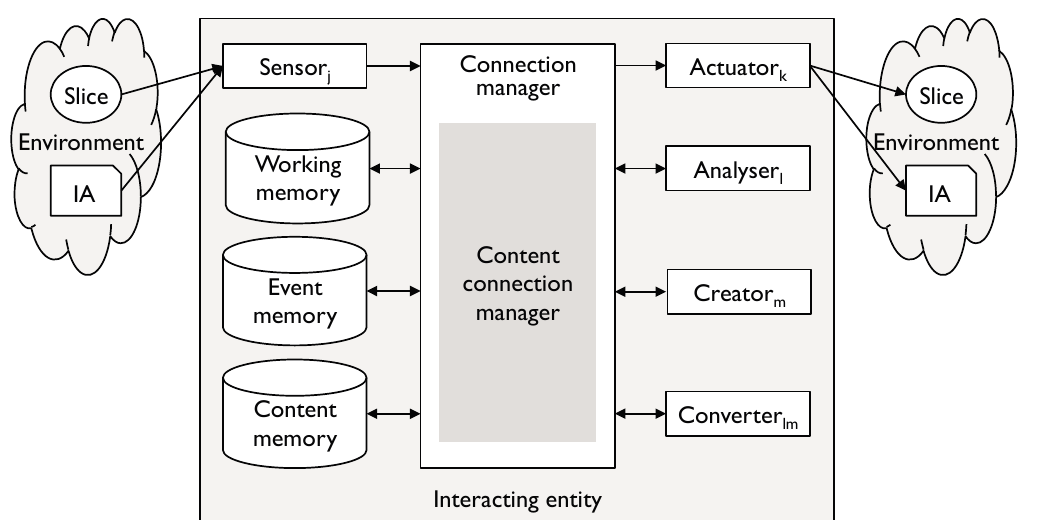
Figure 4. The generic IE and